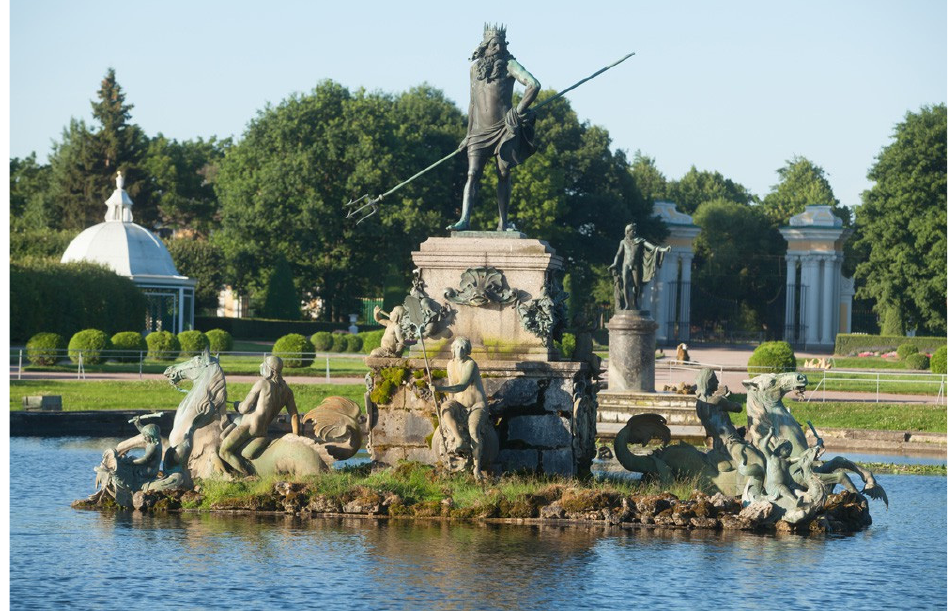
Figure 1. Apollo Belvedere (a bronze copy). Peterhof, near Saint Petersburg.